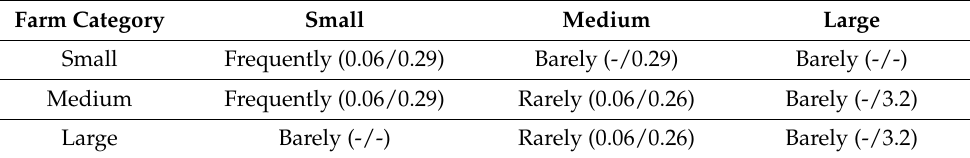
Table 1. Movement structure of pig farming in Vietnam with mean direct/indirect contact rate per week following Poisson distributions in parentheses. Farm Category Small Medium Large Small Frequently (0.06/0.29) Barely (-/0.29) Barely (-/-) Medium Frequently (0.06/0.29) Rarely (0.06/0.26) Barely (-/3.2) Large Barely (-/-) Rarely (0.06/0.26) Barely